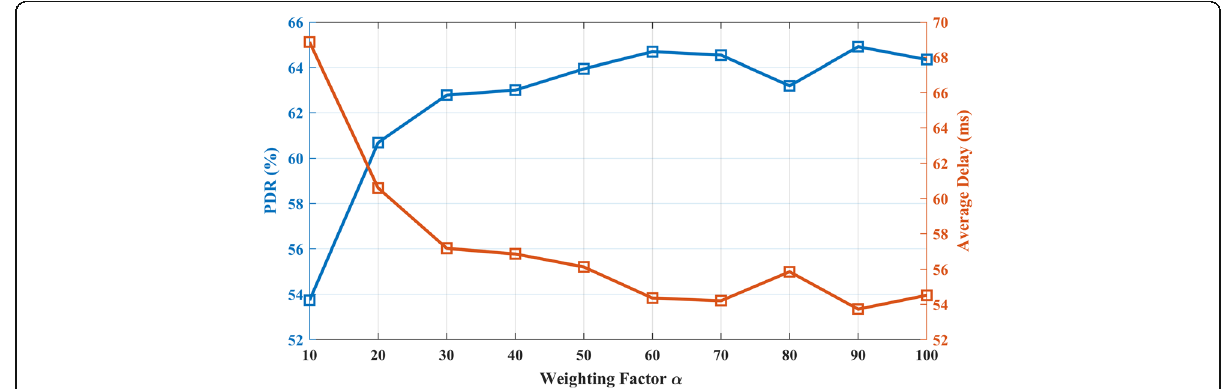
Fig. 4 PRR (percent) and average delay (ms) with varying weighting